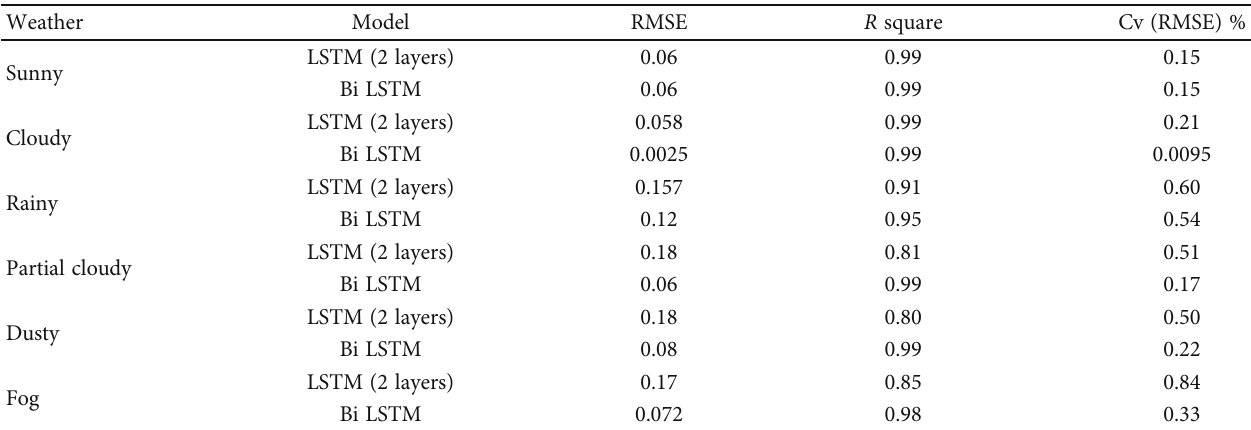
Table 3: Hourly forecast of PV power output using LSTM and Bi-LSTM, RMSE, R square, and Cv (RMSE) of the respective model.